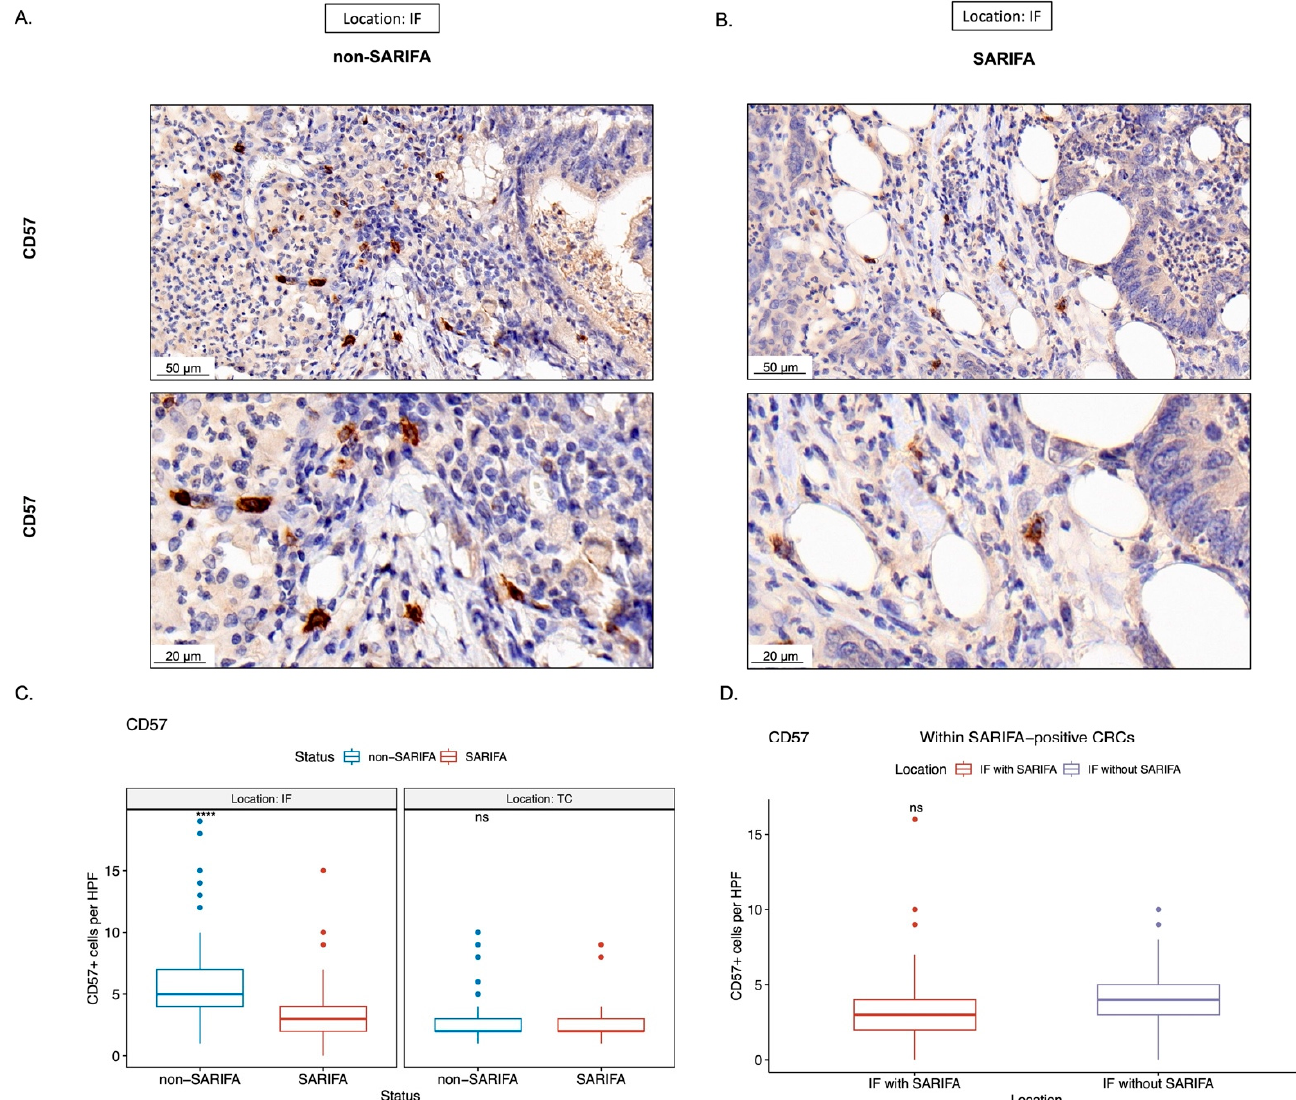
Figure 5. Representative immunohistochemical stains for CD57 ( A and B ; scale bar = 50 µm and 20 µm, respectively). Boxplots showing the amount of CD57+ lymphocytes per high-power field (HPF, 400×), comparing between SARIFA-positive (SARIFA) and SARIFA-negative CRCs (non-SARIFA) at IF and TC ( C ) , and comparing SARIFAs vs. non-SARIFAs, only within SARIFA-positive CRCs ( D ) as SARIFA-positive CRCs also show non-SARIFAs at the invasive margin (see Figure 1E). ns = not significant (at p < 0.05). **** for p < 0.0001.